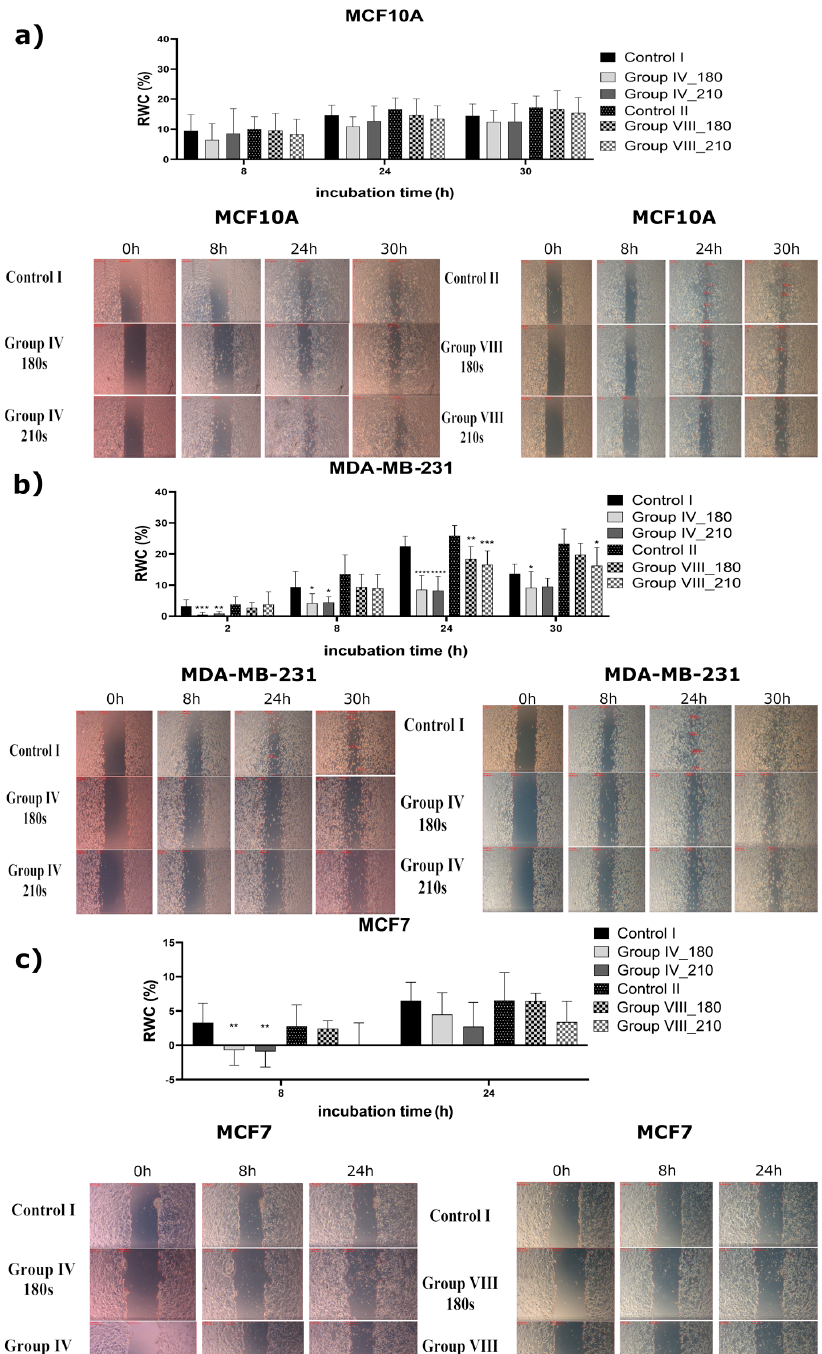
Figure 3. The results of the scratch test assay employed to assess the cells migration for the human breast cell line MCF10A ( a ) and the human cancer cell lines, i.e., MDA-MB-231 ( b ) and MCF7 ( c ). The grown confluent layers were scratched, and old culture media were substituted by: (i) 1.5 mL of the DMEM activated by CAPP for 180 s or 210 s (Group IV) or (ii) 1.5 mL of the Opti-MEM activated by CAPP for 180 s or 210 s (Group VIII). The relative wound closure (RWC) area was calculated following 30 h of the experiment as described in the “Materials and Methods” section.